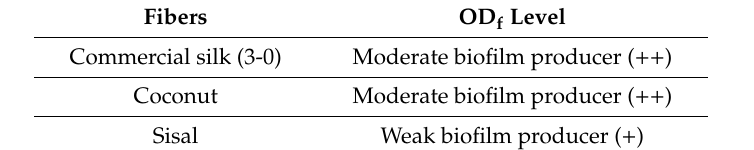
Table 1. Categorizing of biofilm production level of coconut, sisal and commercial silk sutures (3-0).